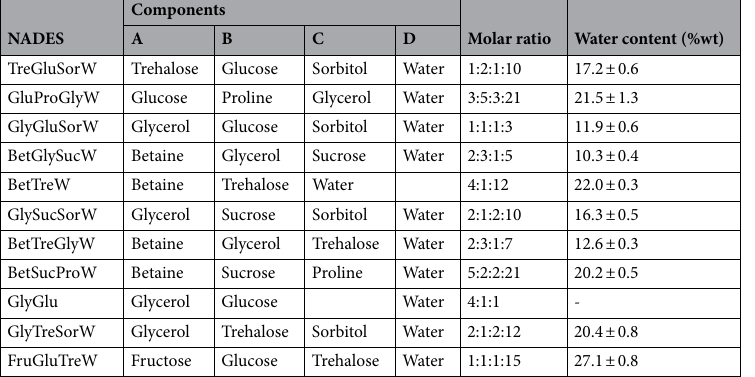
Table 1. Composition of NADES used in this